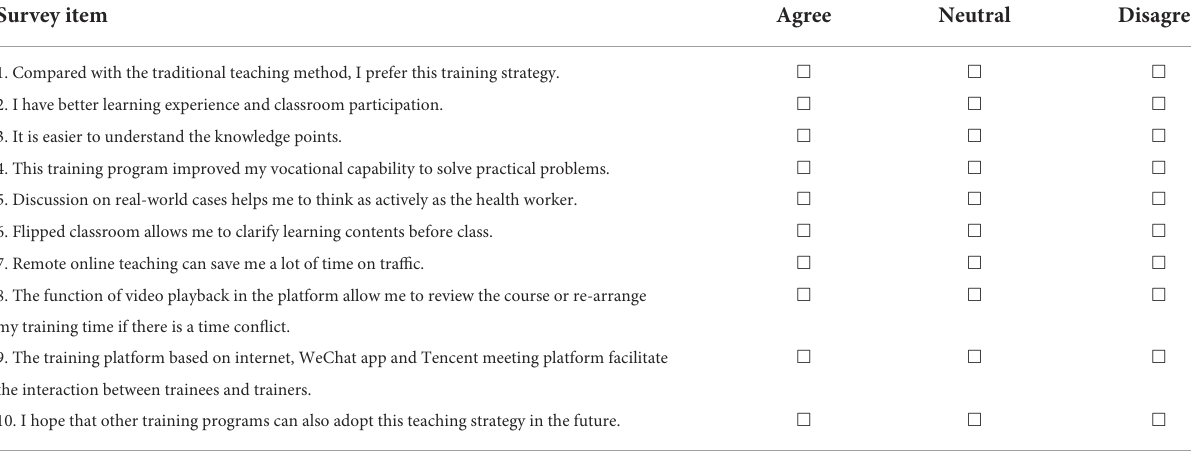
TABLE 2 Questionnaire of continuing training program for community pharmacist. Survey item